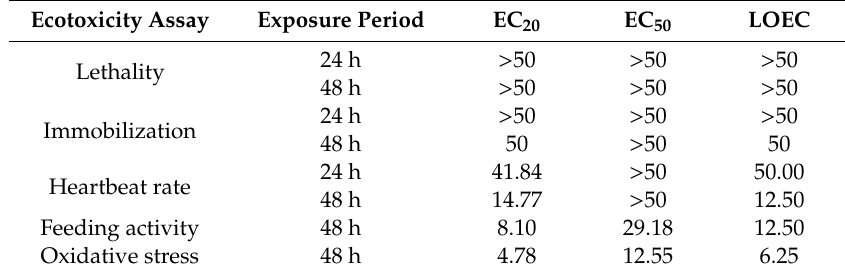
Table 3. E ff ective concentration (EC) and lowest observed e ff ect concentration (LOEC) values [mg / L] of GO for the applied ecotoxicity assays with D. magna after 24 and 48 h exposure.